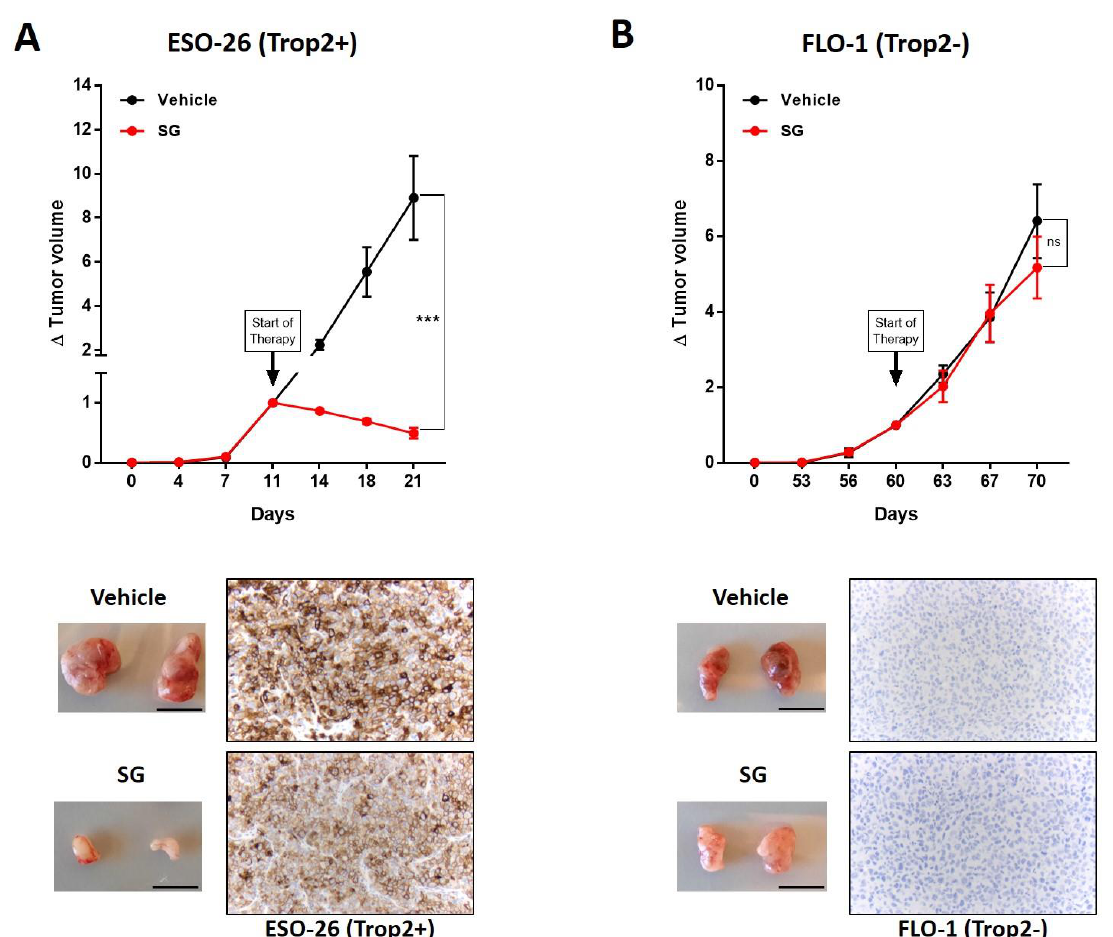
Figure 2. Subcutaneous xenografts of ESO-26 ( A ) and FLO-1 ( B ) were treated with SG or vehicle. Tumor volume relative to the volume at therapy initiation ( ∆ tumor volume) is presented as means ± SEM, n = 4. Macroscopic view of the dissected tumors (bar = 1 cm) next to IHC stains with anti-TROP2 antibody (200×) after vehicle or SG treatment is shown below, *** p -value < 0.001, two-sided unpaired Student ’ s t -test.